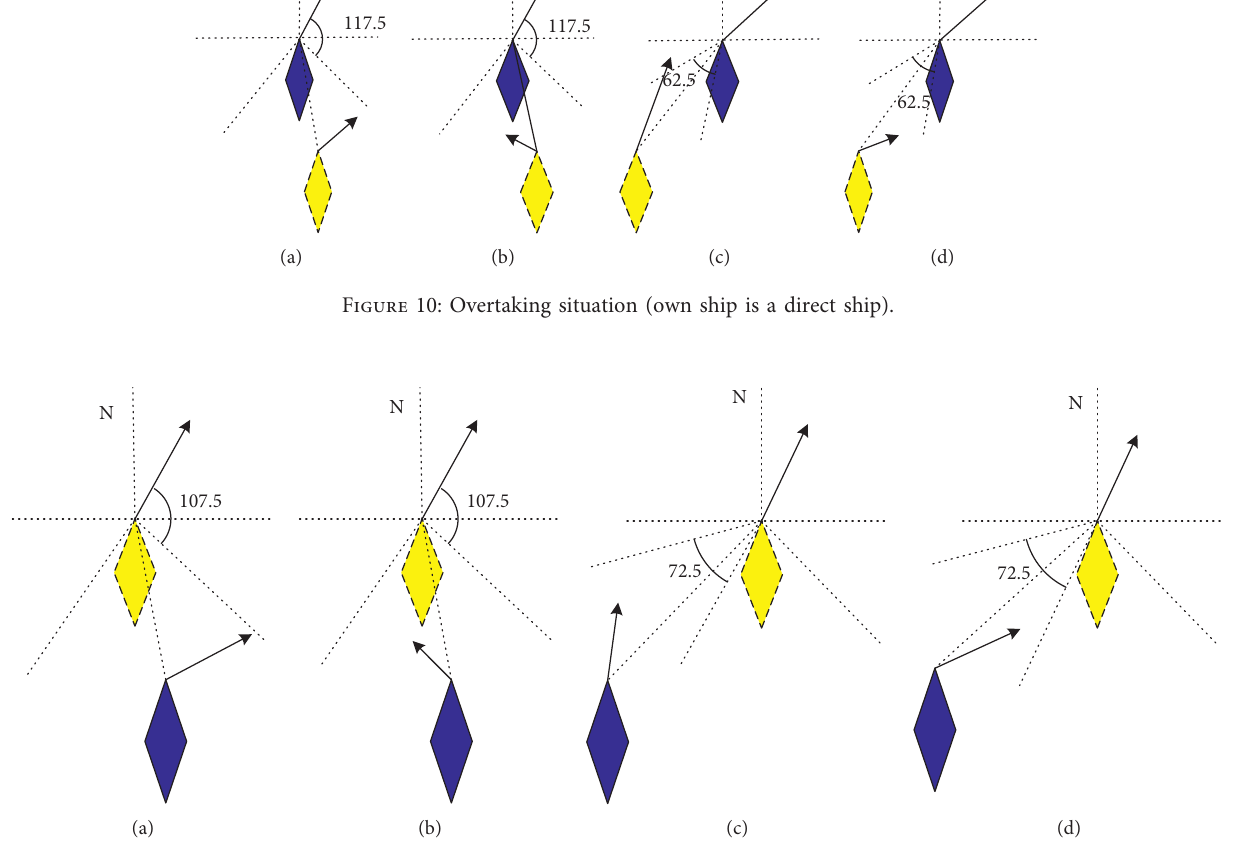
Figure 11: Overtaking situation (own ship is overtaking